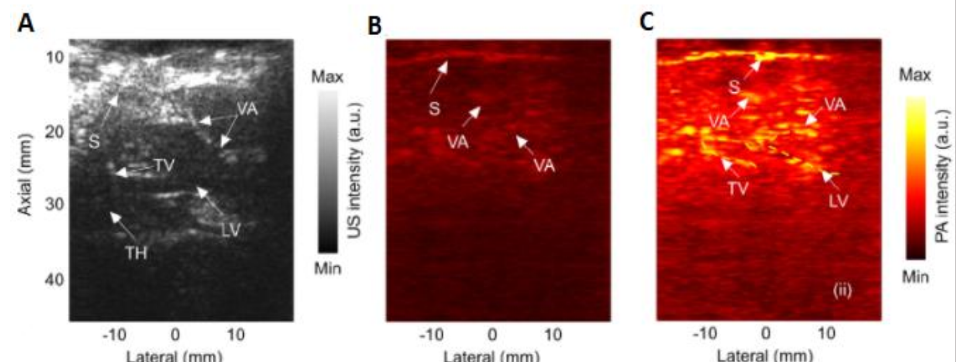
Figure 4. Performance evaluation of trained U-Net kernel based on in vivo sheep brain images. ( A ), US image along the sagittal plane. ( B ), PA image generated with a low energy laser; ( C ), deep learning enhanced PA image in ( B ). S, skin; LV, lateral ventricle; TV, third ventricle; TH, thalamus; VA, vasculature. Yellow contours indicate some of the structures that were not present in B (Reprinted with permission from Ref. [59]. 2020,